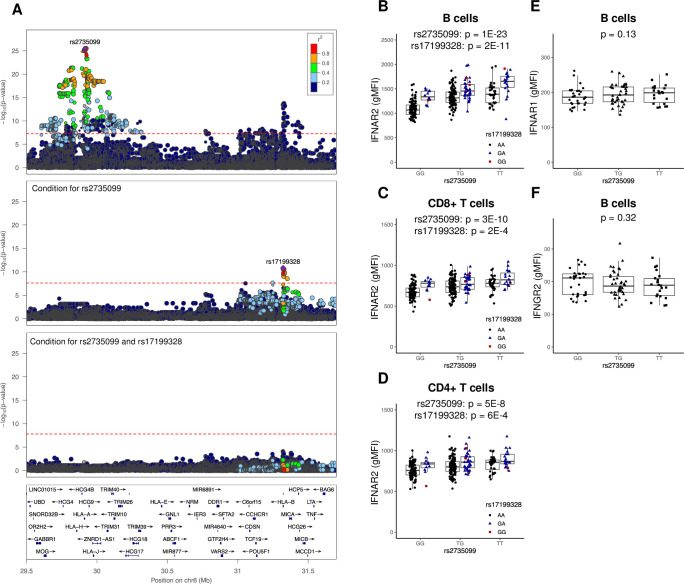
Two independent SNPs additively associate with IFNAR2 protein levels in B cells and T cells.(A) Regional association plots of the trans-IFNAR2 pQTL in B cells before (top) and after conditioning for rs2735099 (middle) and rs17199328 (bottom). (B-D) Boxplots of IFNAR2 levels in B cells (B), CD8+ T cells (C) and CD4+ T (D) cells stratified by rs2735099 and rs17199328 (n = 301). (E-F) IFNAR1 (E) and IFNGR2 (F) surface levels in B cells (n = 95). p-values from the full model using single (A, E and F), or two additive SNPs (B-D). Boxplots show median, IQR and range. gMFI = geometric mean fluorescence intensity.